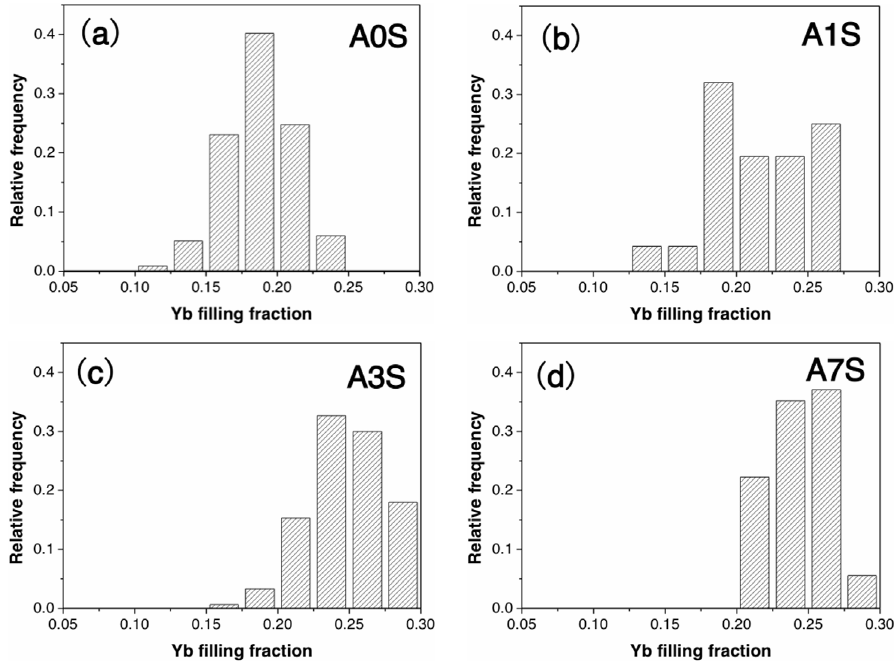
Fig. 4 Yb filling fraction distribution in the samples A0S, A1S, A3S, and